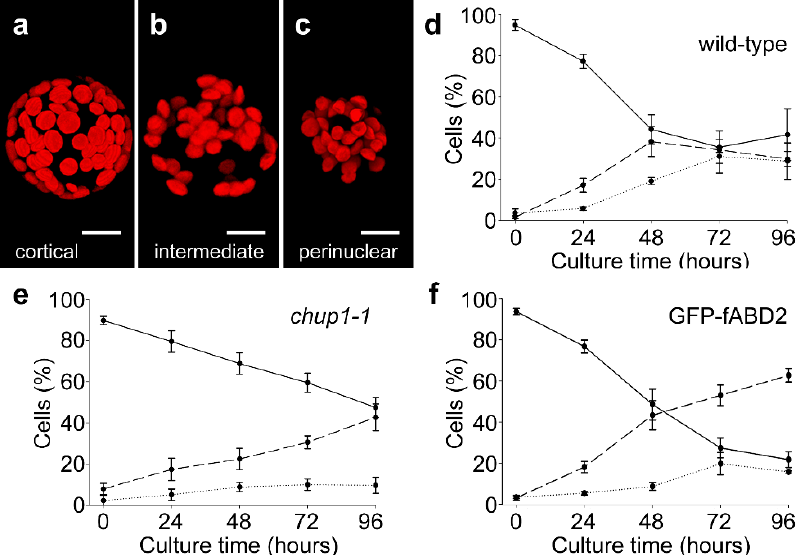
Figure 1. Analysis of chloroplast clustering in Arabidopsis protoplasts. ( a – c ) Images of chloroplasts (red autofluorescence) in either the ( a ) cortical, ( b ) intermediate, or ( c ) perinuclear distributions in cultured protoplasts. (d ‐ f) Quantitative analysis of the repositioning of chloroplasts from cortical to perinuclear across 96 h of culture. ( d ) Wild ‐ type protoplasts. ( e ) chup1 ‐ 1 protoplasts. ( f ) Protoplasts from a GFP ‐ fABD2 line. For d–f, solid lines, dashed lines and dotted lines represent cortical, intermediate and perinuclear distributions of chloroplasts, respectively. Scale bars in a–c = 10 μ m. Data in d ‐ f is mean ± SE, n = 3–5 experiments.